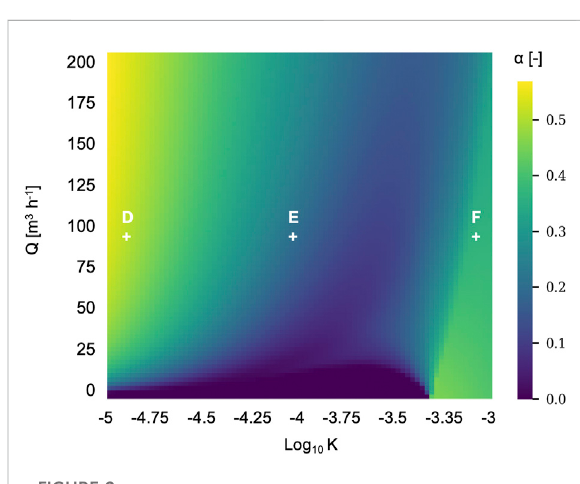
FIGURE 2 Distribution of the mixing ratio α depending on the hydraulic conductivity K and pumping discharge Q